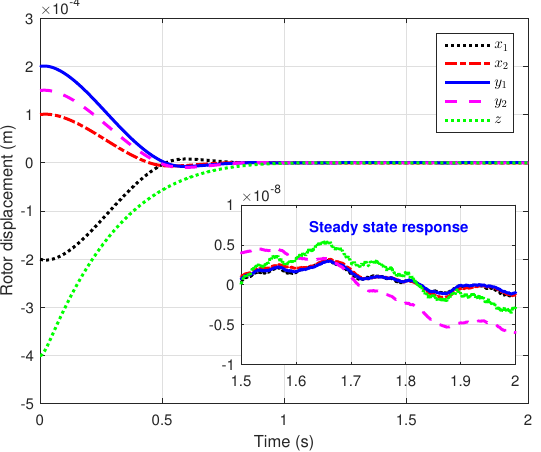
Figure 5. The responses of rotor positions under